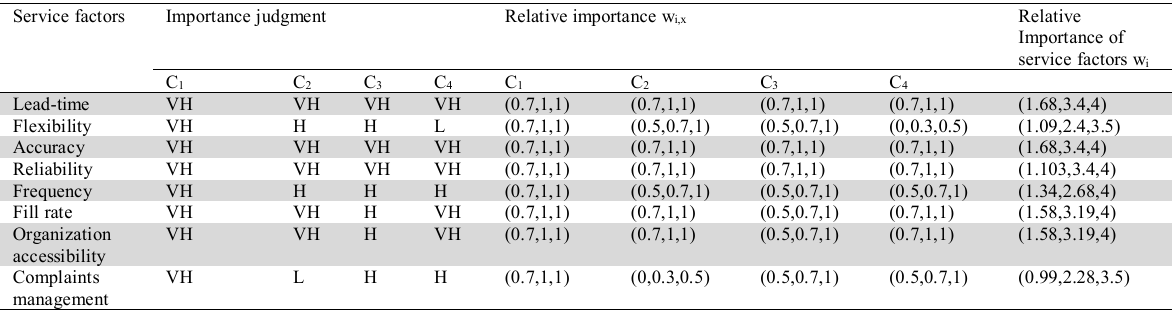
Fuzzy importance w assigned to service factors by each customer and the relative importance of service i,x factors W